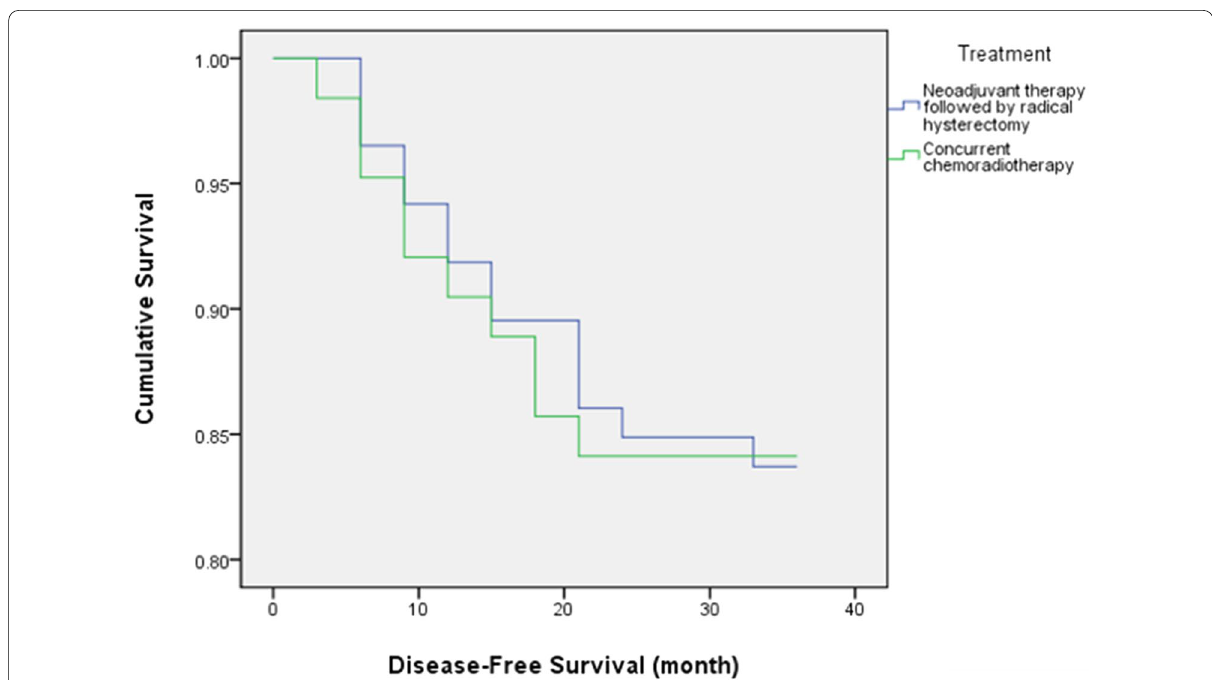
Fig. 4 The DFS curves for NAT